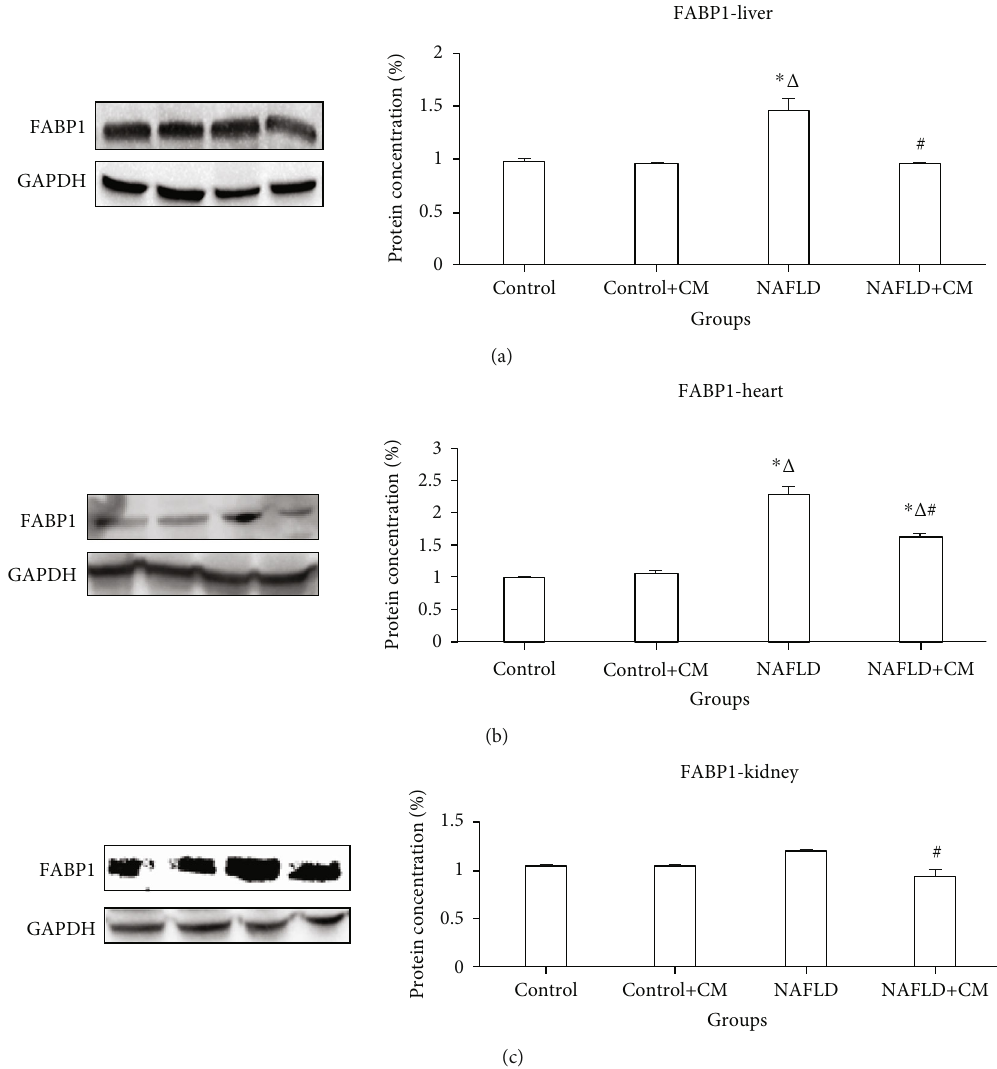
Figure 4: FABP1 protein expression in the liver (a), heart (b), and kidney (c) tissues of the control, camel milk (CM) treated control (control+CM), nonalcoholic fatty liver disease (NAFLD), and CM-treated NAFLD (NAFLD+CM) animals. The protein bands were quanti fi ed relative to GAPDH. ∗ p < 0 : 05 versus the control group, Δ p < 0 : 05 versus the control+CM group, and # p < 0 : 05 versus the NAFLD